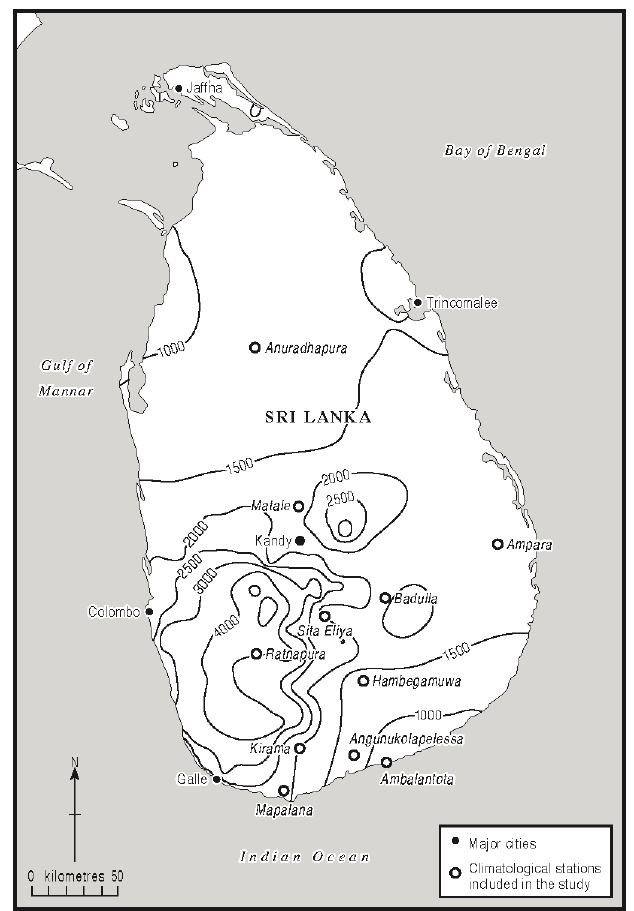
Figure 1. Mean annual rainfall distribution of Sri